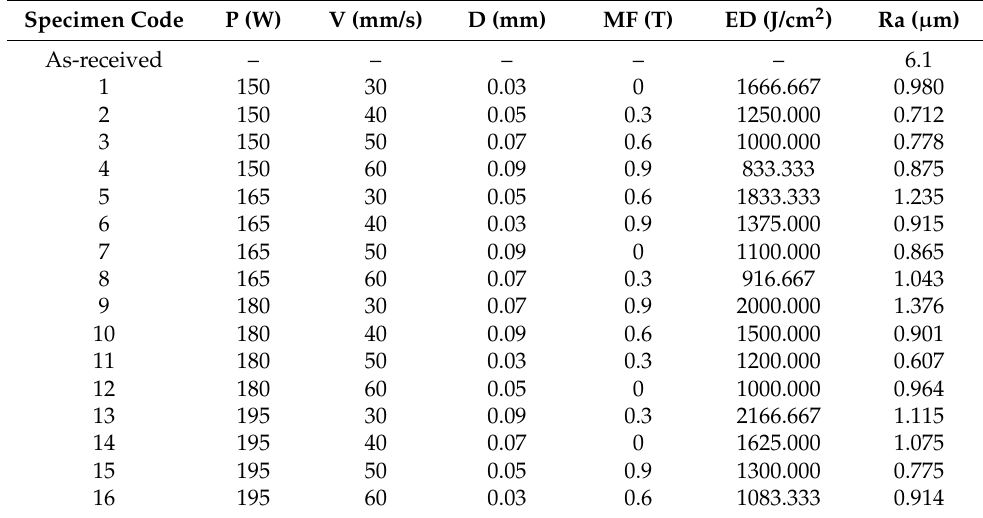
Table 2. L16(4 4 ) magnetic field-assisted CW laser orthogonal test